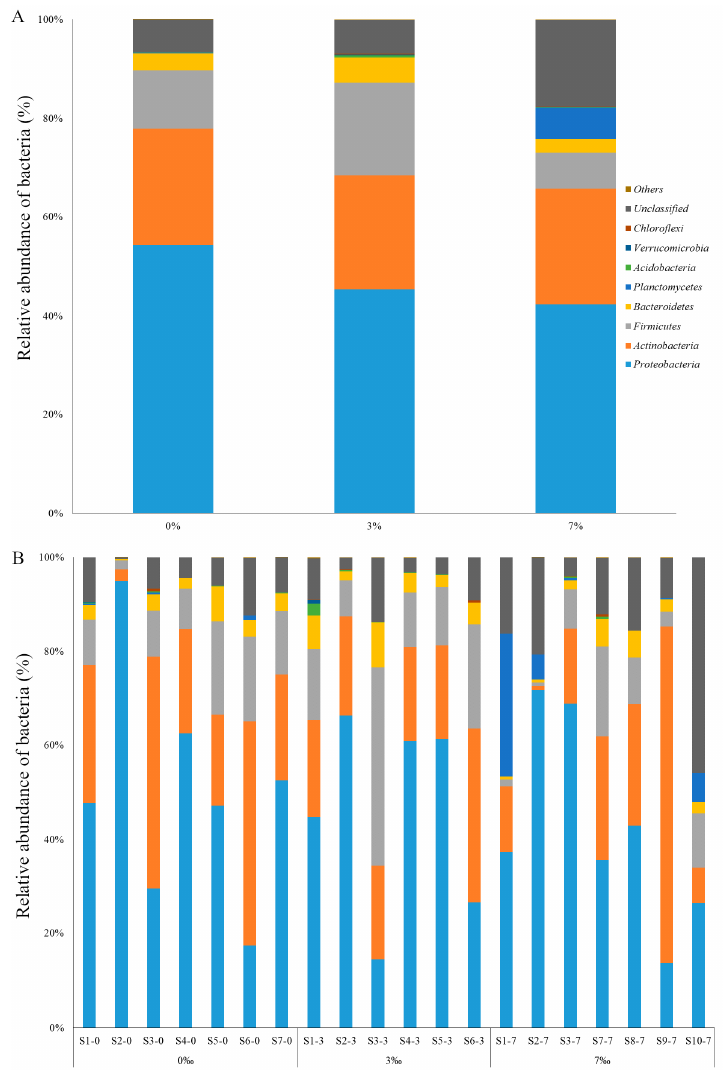
Figure 3. Relative abundance (%) of the most prevalent bacterial phyla in three groups kept at different levels of salinity ( A ) and in individual pike ( B ). Figures show all phyla with an abundance > 0.5%. Phyla with an abundance ≤ 0.5% are pooled and labeled as “Others”.